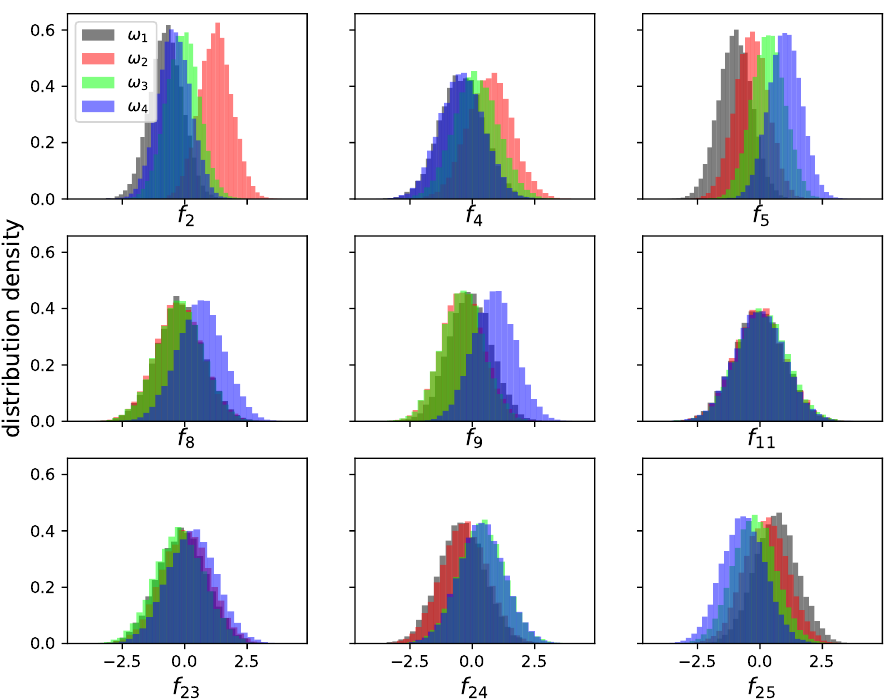
Figure 4. Single-feature histograms for selected example features of the training data from the simulated test image